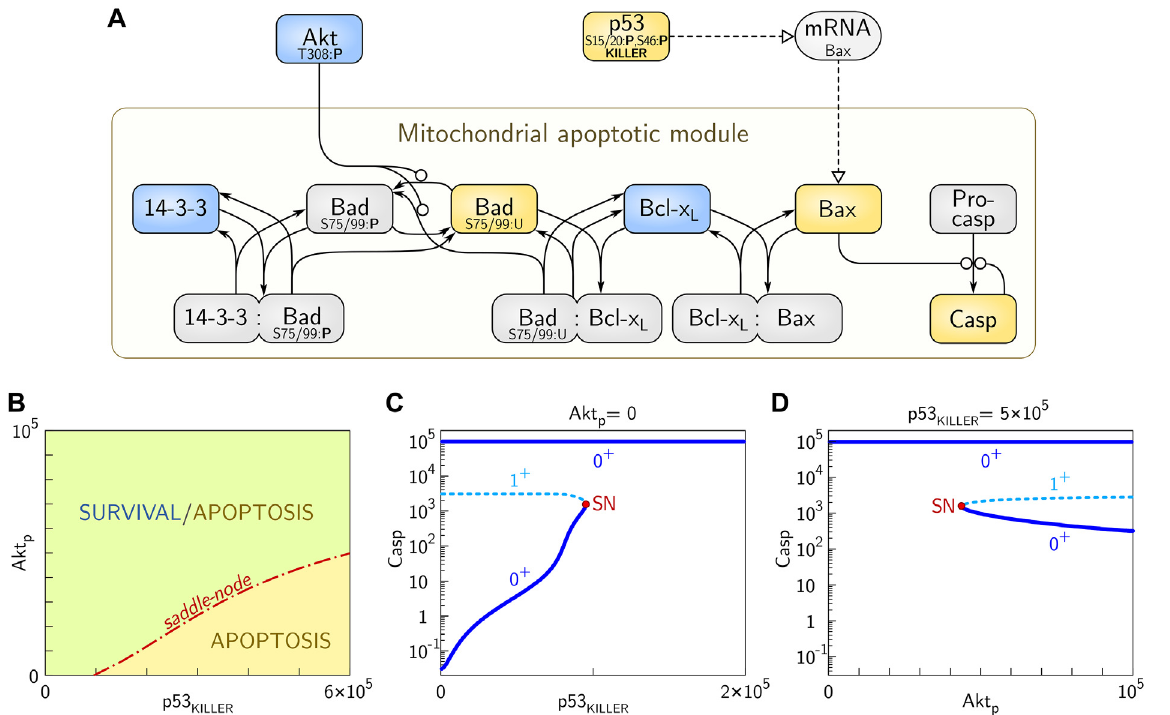
Fig 3. Scheme and the bifurcation diagrams for the apoptotic module. (A) Scheme: pro-survival proteins are in blue boxes, pro-apoptotic proteins are in yellow boxes, other proteins or protein complexes are in gray boxes. The arrow notation is same as in Fig 1. (B) Saddle — node bifurcations line in the (p53 KILLER , Akt p )-plane (2-D bifurcation diagram) separates the region of parameters for which apoptotic and survival states coexist from the region for which only the apoptotic state exists. (C) Bifurcation diagram for Casp vs. p53 KILLER (bifurcation parameter) for Akt p ; the saddle-node bifurcation point SN is (p53 KILLER , Casp bif ) ffi (0.95×10 5 , 1.5×10 3 ). (D) Bifurcation diagram for Casp vs. Akt p (bifurcation parameter) for p53 KILLER ffi 5×10 5 ; the saddle-node bifurcation point SN is (Akt p , Casp bif ) ffi (4.4×10 4 , 1.5×10 3 ). The solid and dashed lines correspond respectively to the stable and unstable steady states. The number of eigenvalues with positive real parts is either one (1 + ) for the unstable steady state or zero (0 + ) for stable steady states. Notice the logarithmic scale on vertical axes in (C) and (D).